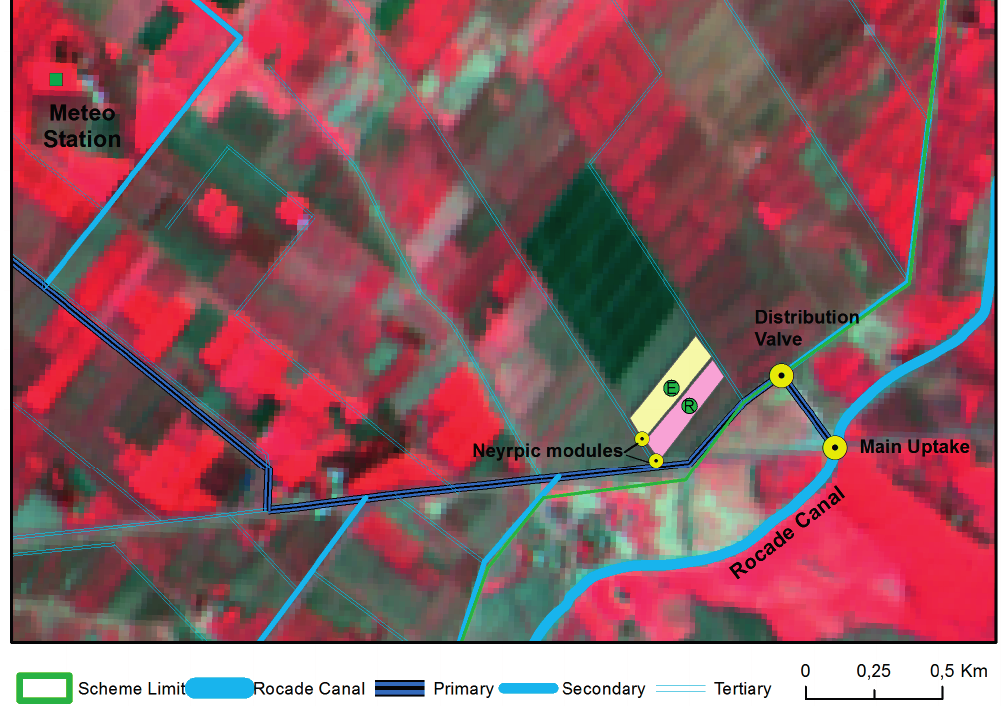
Figure 2. Setup at the south of the scheme: The experimental plot (yellow) is located north of the reference plot (pink) at a distance of about 1km from the main canal. A flux tower (green circle) was installed at the center of each plot (E stands for “experimental”, and R, for “Reference”). The meteorological station (green square) is located 2 km west of the